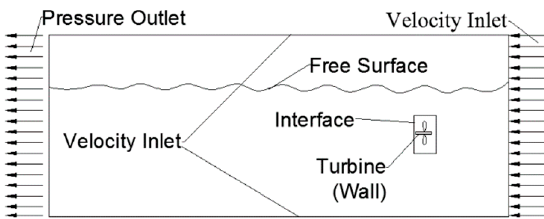
Figure 3. Schematic diagram of boundary conditions.